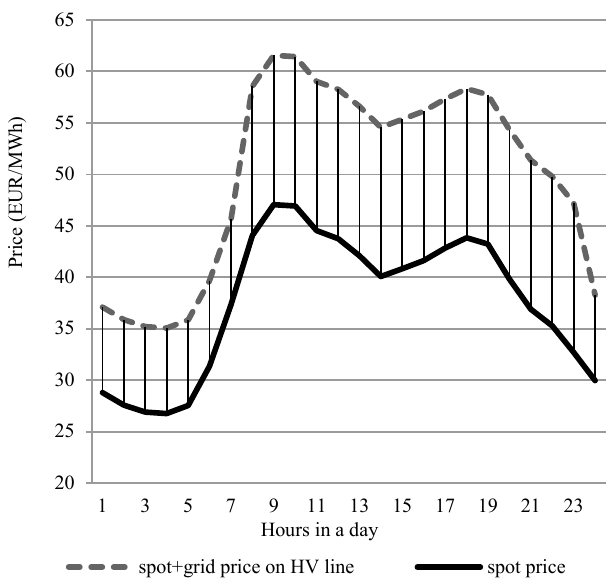
Fig. 1. Average Estonian 2014 electricity spot price during a